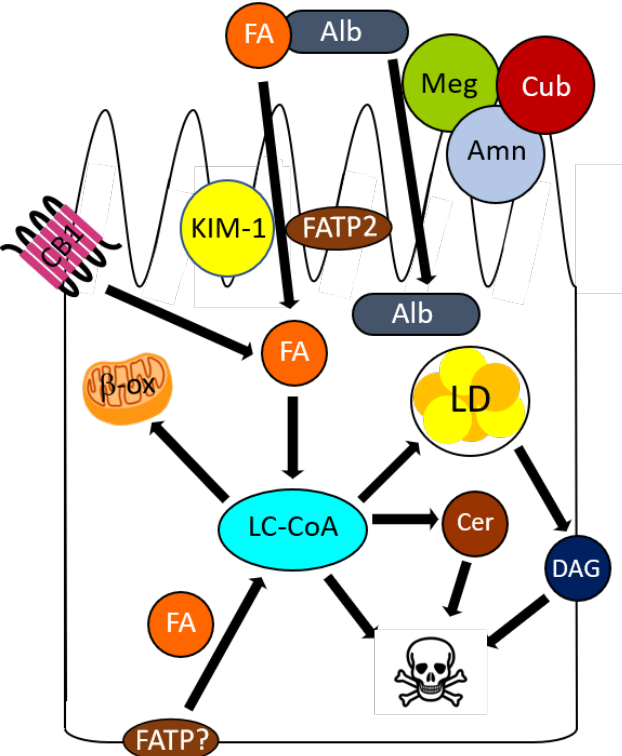
Figure 2. Lipotoxicity in the proximal tubule cell. Under pathologic (albuminuric) circumustances, fatty acids are taken up by transporters at the basolateral and apical membranes. At the apical surface, fatty acids and albumin dissociate and are transported by separate mechanisms. If the accumulated lipids exceed the capacity to undergo β -oxidation within mitochondria or storage within lipid droplets, toxic fatty acid metabolites (ceramides, diacylglycerols, long-chain acyl-CoAs) cause apoptosis and tubular atrophy. Abbreviations: albumin (Alb), amnionless (Amn), cannabinoid receptor type 1 (CB1), ceramide (Cer), cubilin (Cub), diacylglycerols (DAG), fatty acid (FA), fatty acid transport protein (FATP), kidney injury molecule-1 (KIM-1), lipid droplet (LD), low density lipoprotein receptor (LDLR), long-chain acyl-CoAs (LC-CoA), megalin